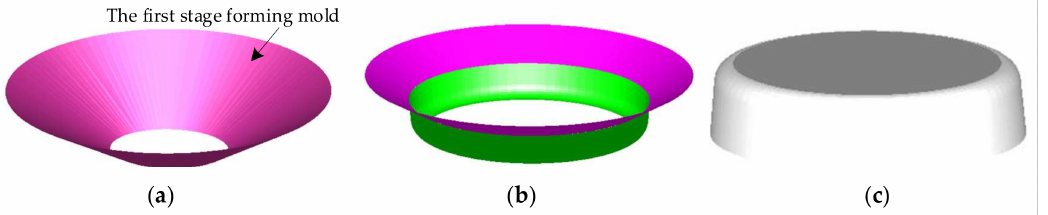
Figure 18. Forming model of each intermediate stage: ( a ) the first stage; ( b ) the second stage; ( c ) the third